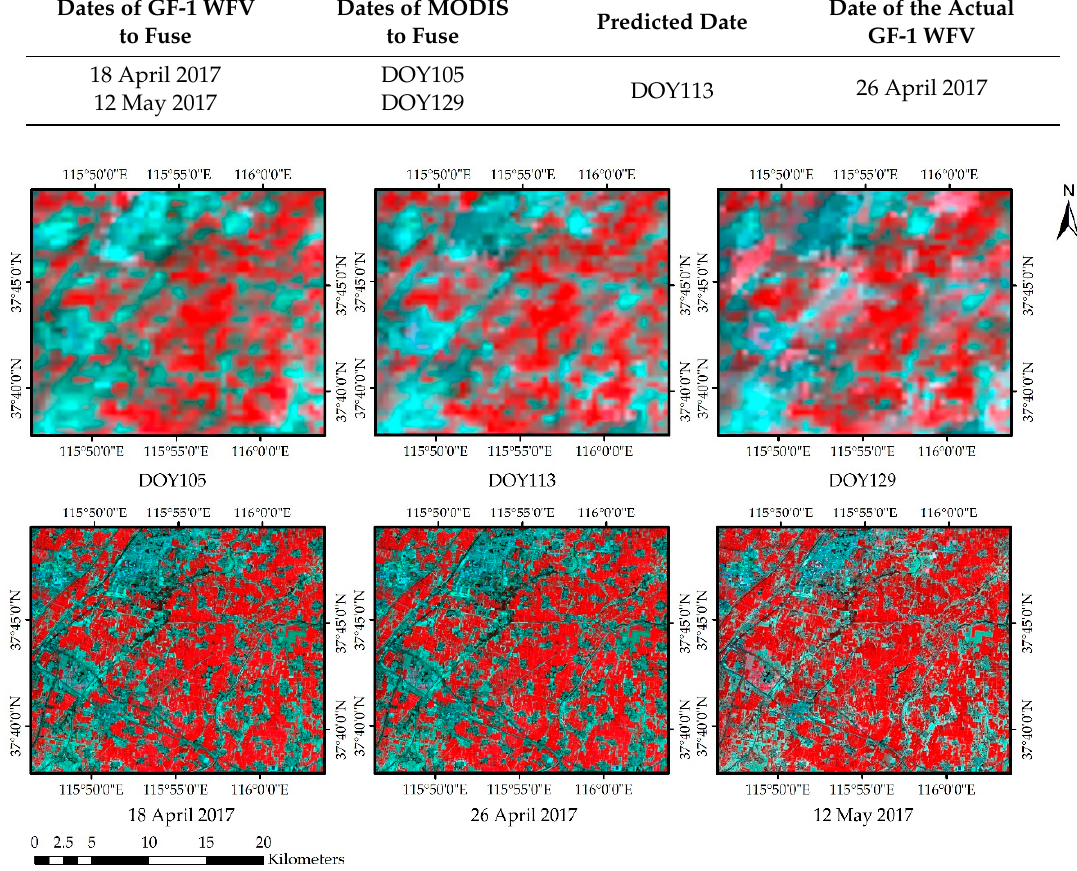
Figure 7. Standard false colour composited MODIS surface reflectance ( upper row ) data and corresponding GF-1 WFV surface reflectance ( lower row ) data.